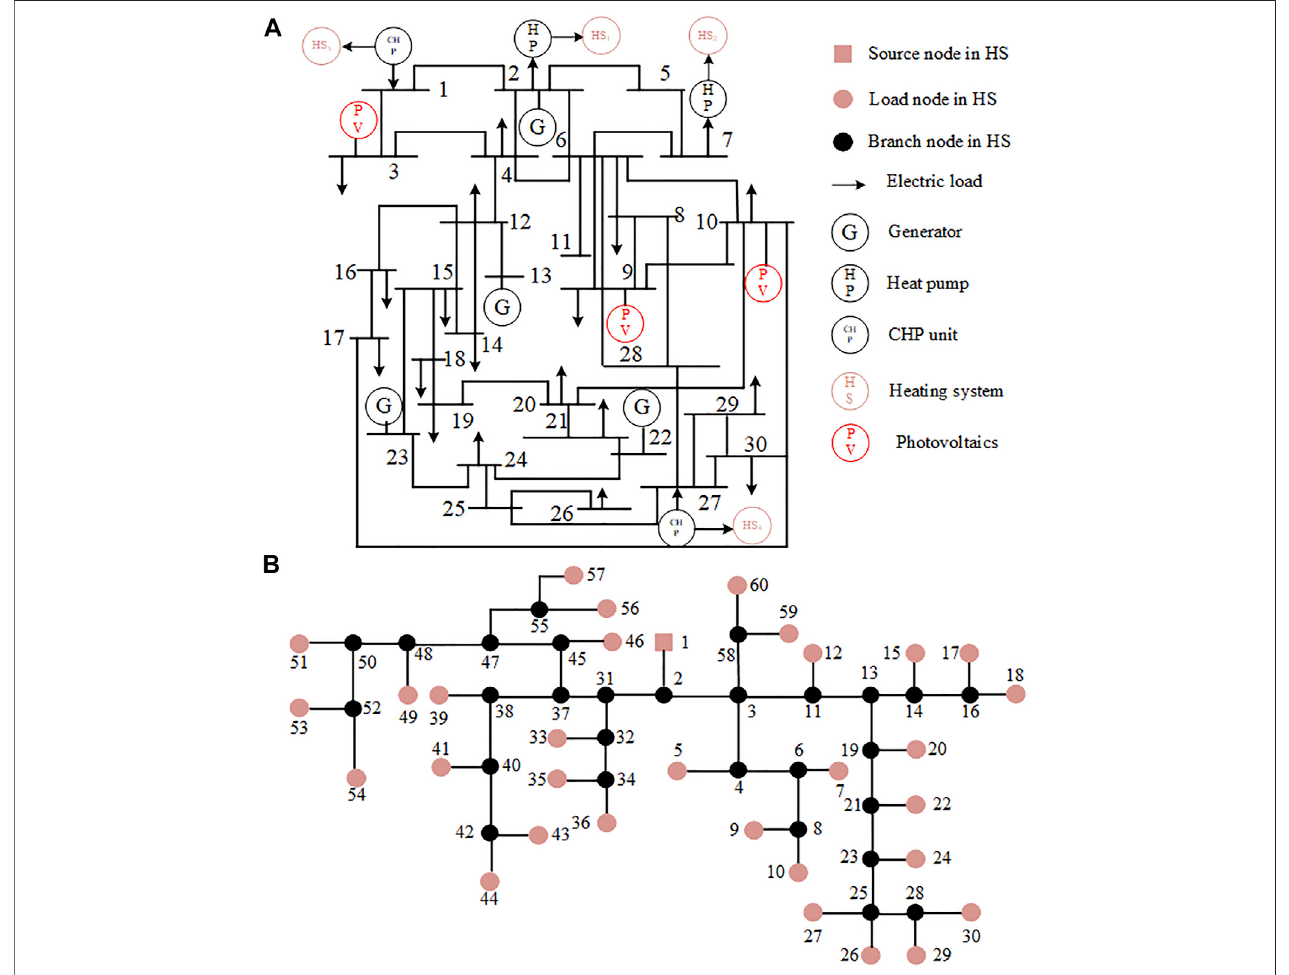
FIGURE 3 | Structure of integrated heat and electricity systems in case study. (A) Structure of power system. (B) Structure of heating system.